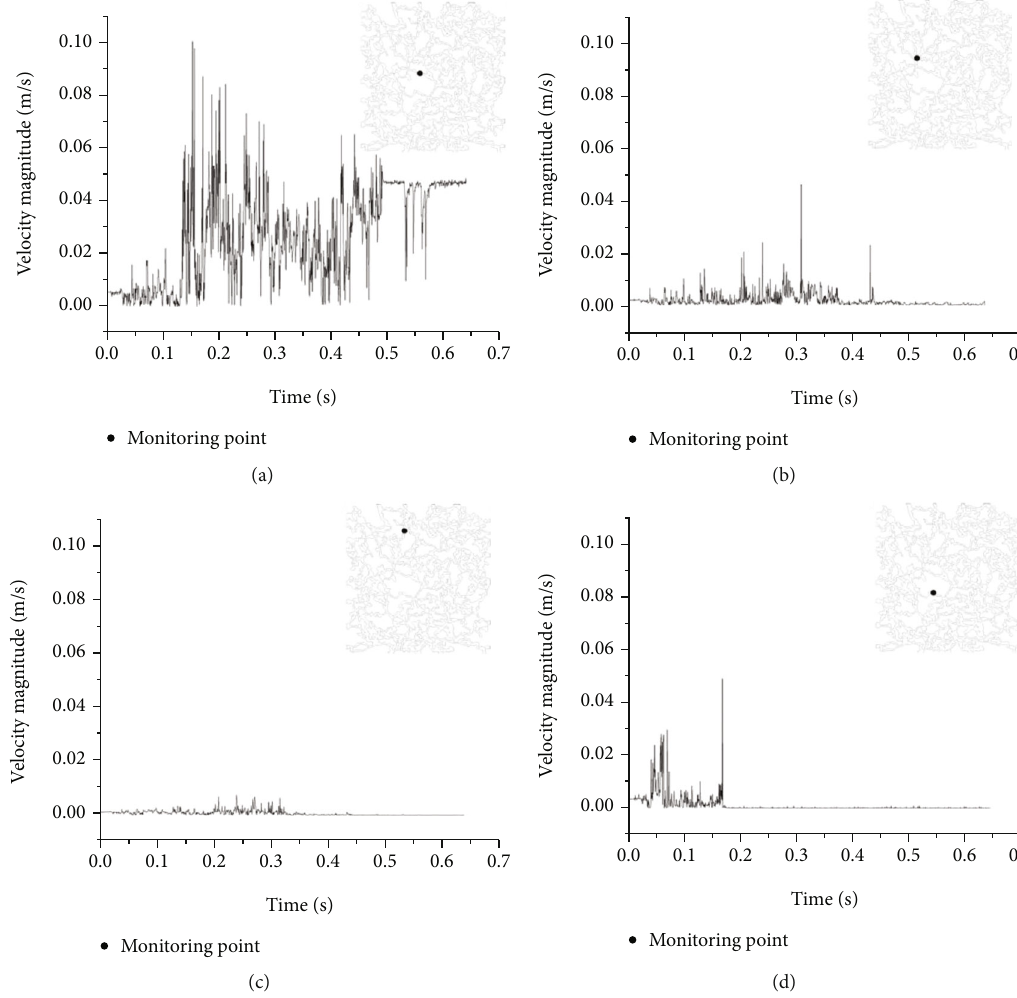
Figure 4: Fluid velocity at di ff erent points versus time. (a) Point 1. (b) Point 2. (c) Point 3. (d) Point